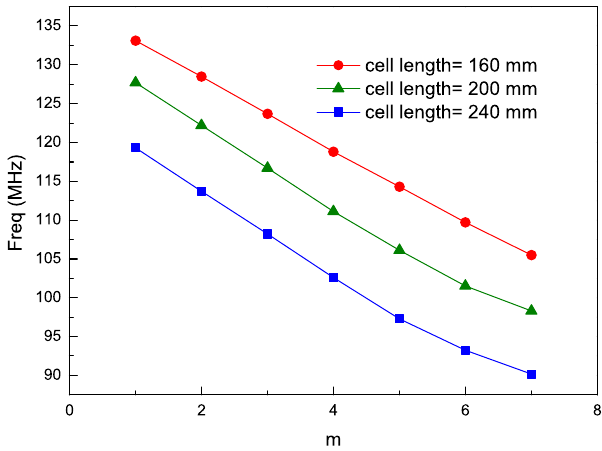
FIG. 15. Frequency of the TE 010 -mode as a function of m for different cell lengths. The parameter m is to be determined such that the TE 010 -mode frequency is close to the operating frequency ω 0 of 108.4 MHz at each section of the cavity.